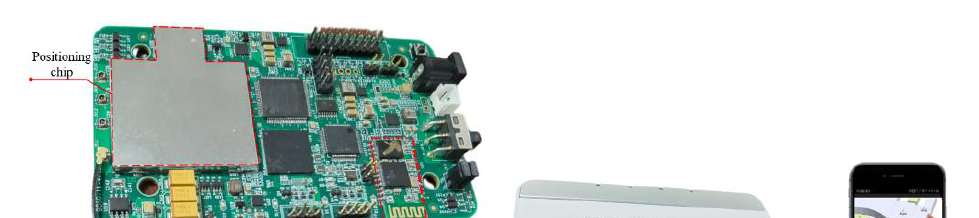
Figure 10. Test environment.